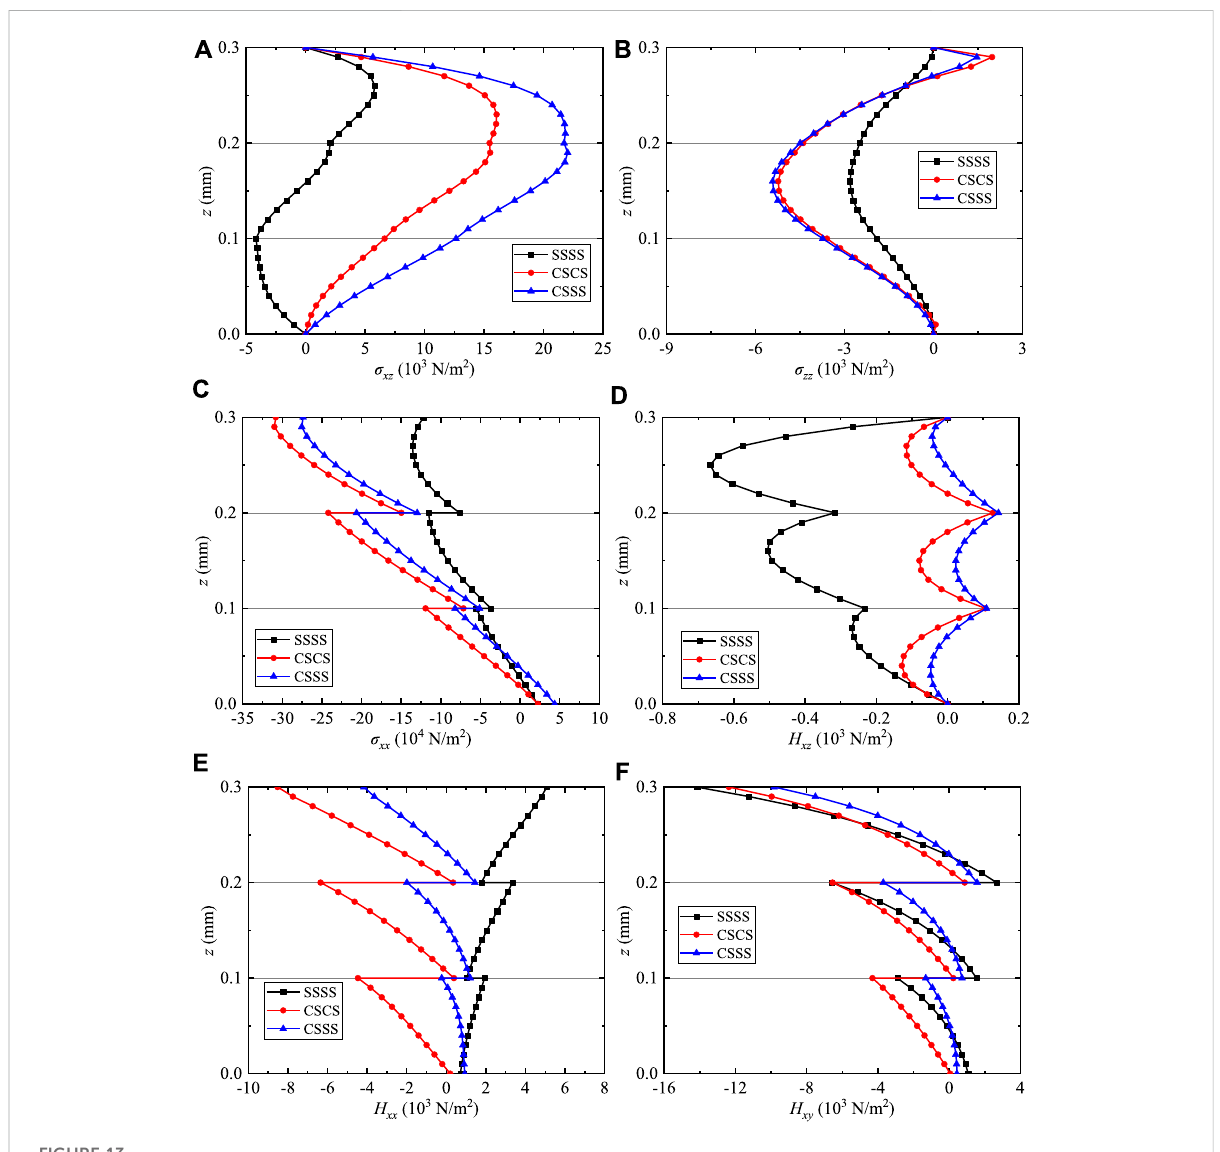
FIGURE 13 Variation of the phonon and phason stresses for QC coating structures: (A) σ xz , (B) σ zz , (C) σ xx , (D) H xz , (E) H xx , and (F) H xy .